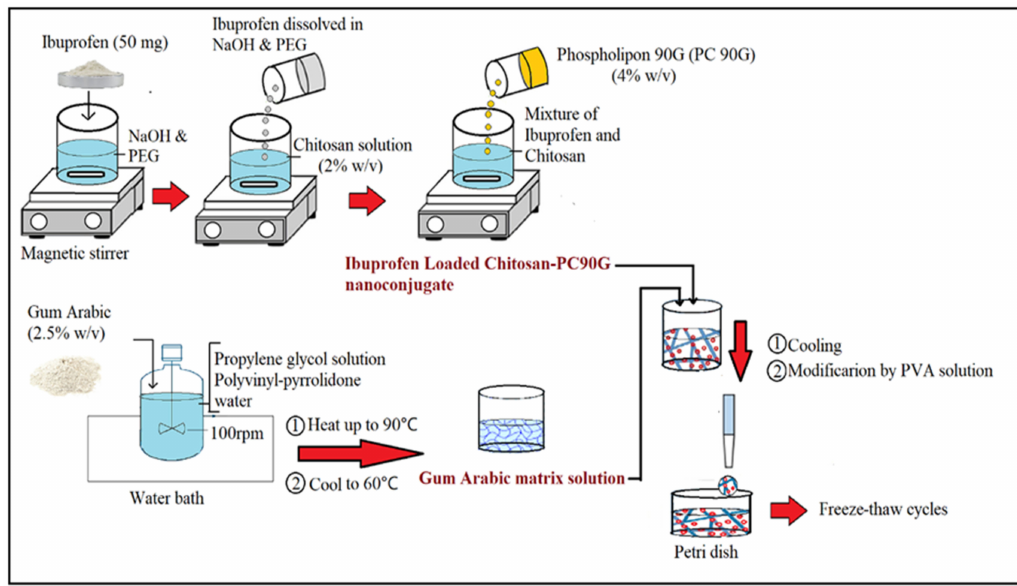
Figure 10. Schematic diagram of the fabrication procedure for IBU nanoconjugate